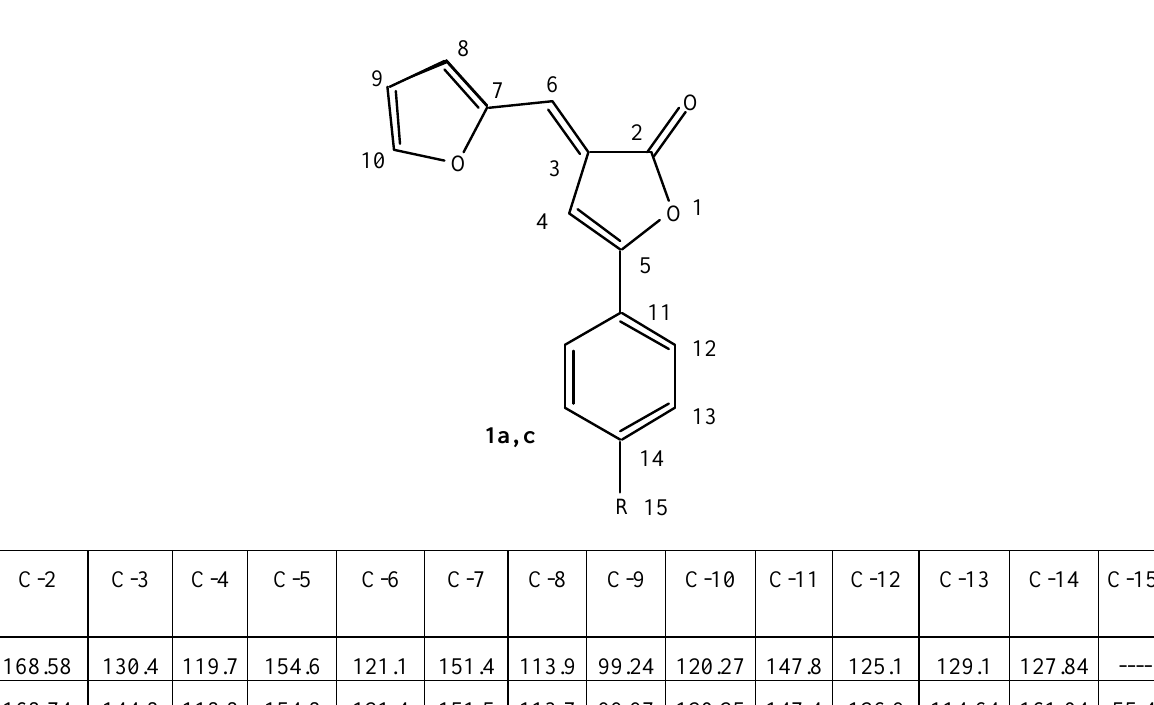
]DMSO) for a -(2-furyl)methylidene-( E )- g -aryl-2(3 H )-furanones 6 1a and 1c